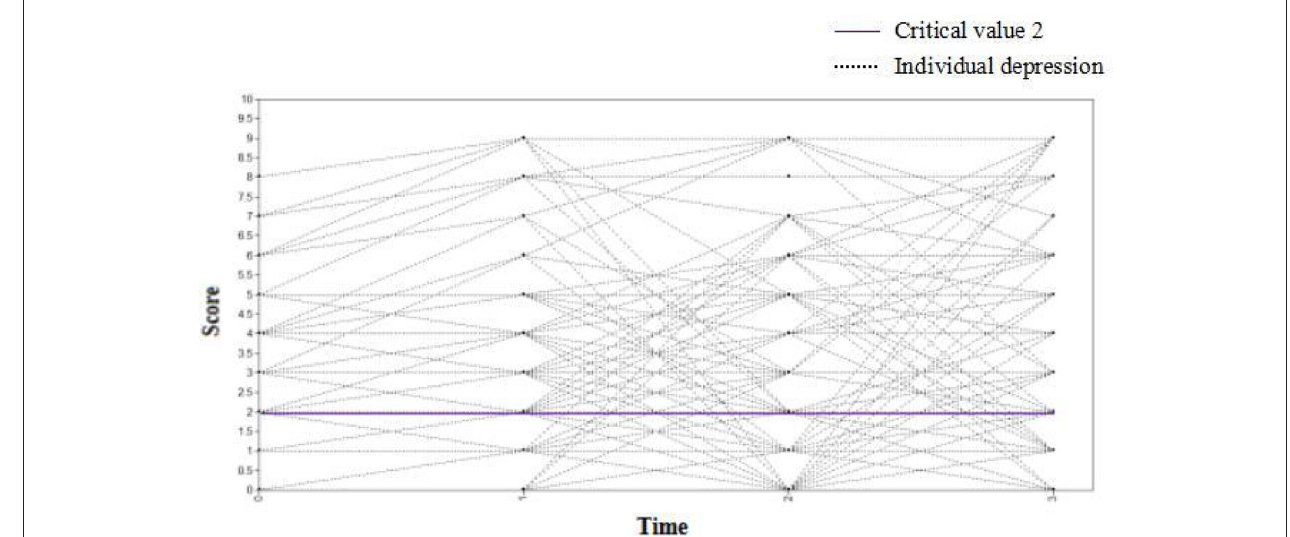
FIGURE 10 | The changing trajectory of depression of the medical staff after